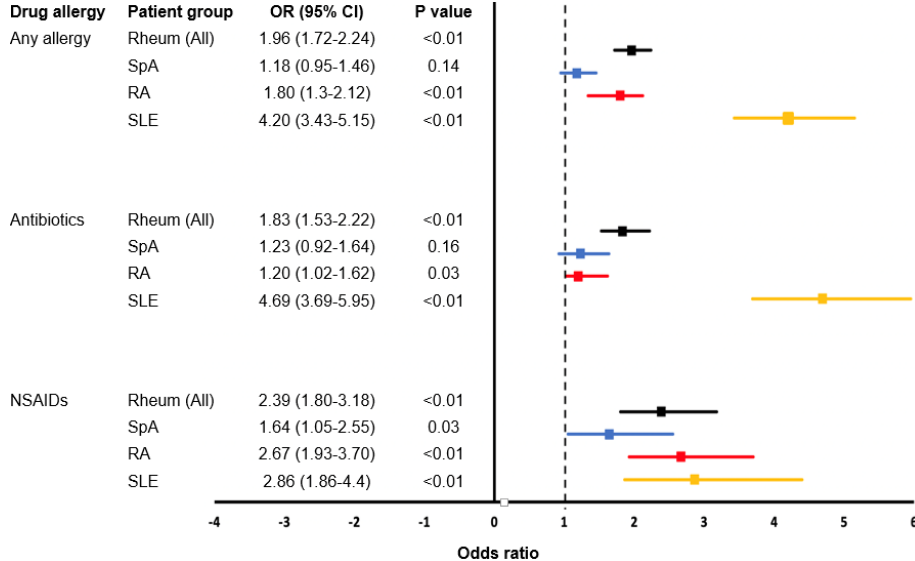
Figure 2. Age- and sex- adjusted odds ratios of DA (by disease and drug categories) compared to controls.